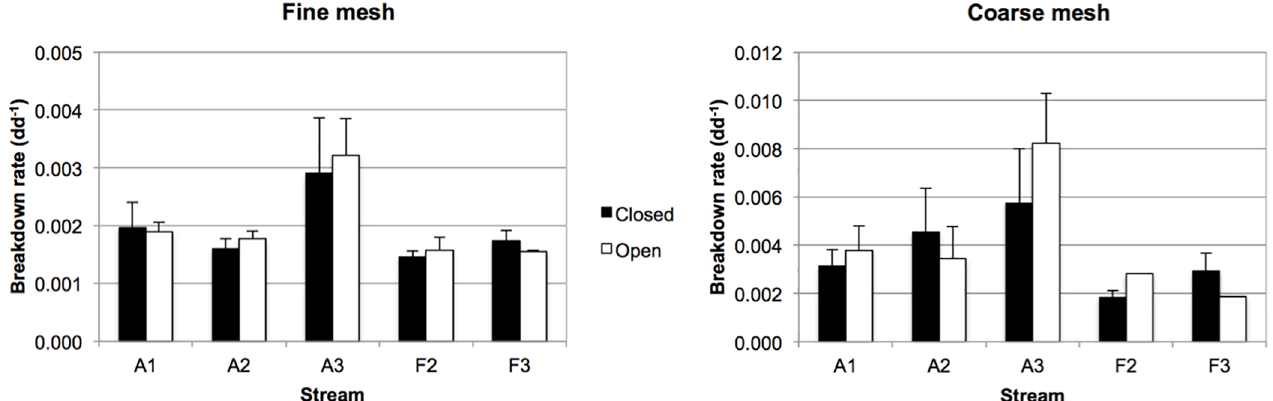
Fig 3. Temperature-corrected breakdown rates. Black columns, closed reaches, white columns, open reaches of agricultural (A) and forest (F) streams. Left panel, fine-mesh bags show microbial decomposition. Right panel, coarse-mesh bags show total decomposition. Values are arithmetic means, error bars show standard deviation. Note the different scale of Y